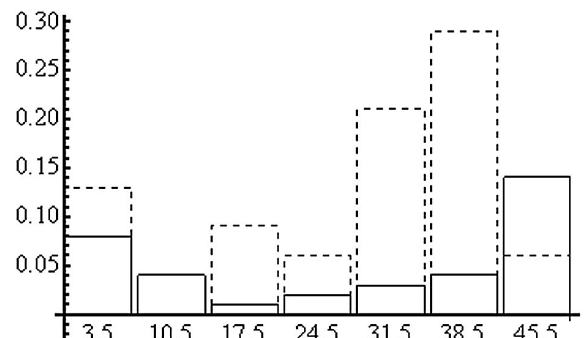
Fig . 7. – Percentage of the initial volume that is beached in one year in the conservative persistence hypothesis according to the hindcast approach (dashed line bars) and to the simple approach (continuous line bars) respectively. Frequencies are normalized to